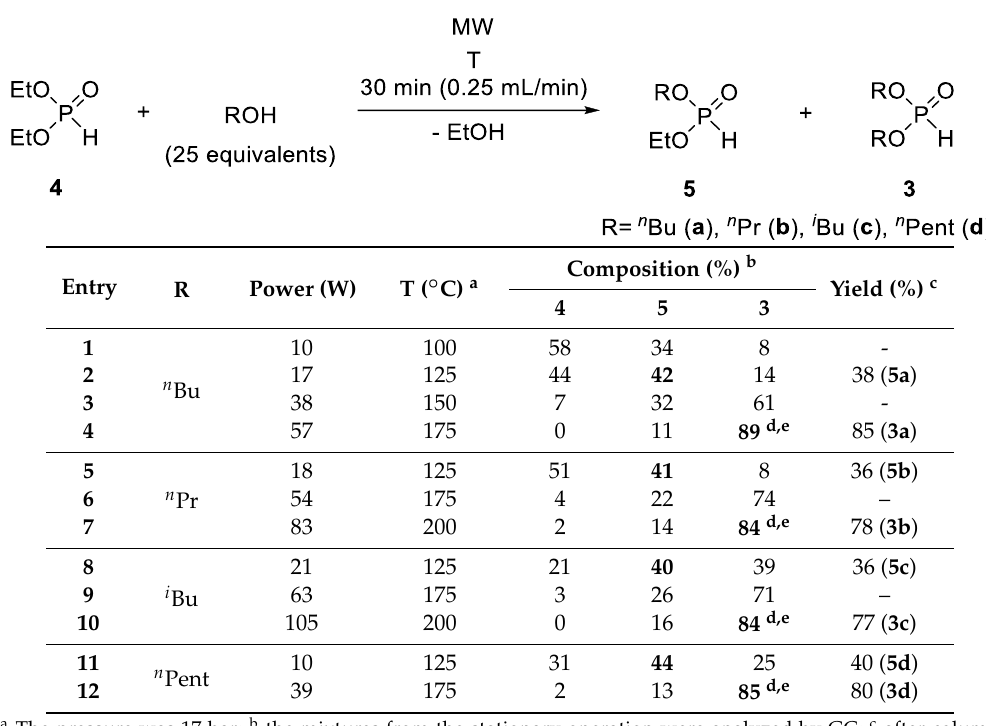
Table 6. Continuous flow alcoholysis of DEP with alcohols.